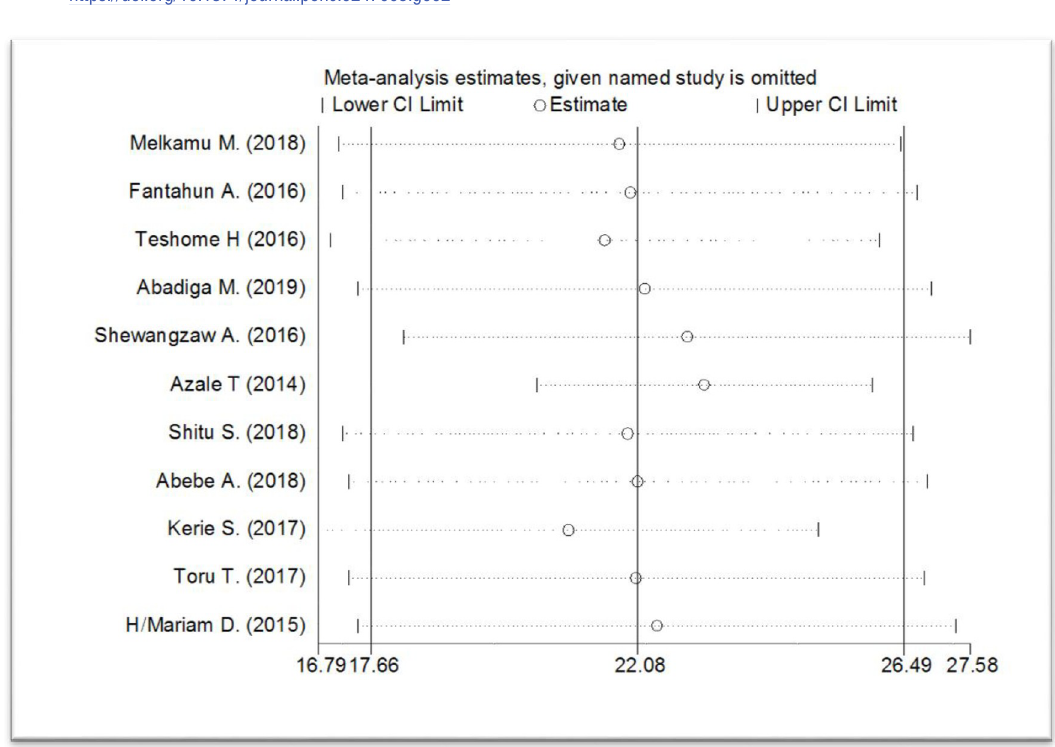
Fig 2. Forest plot presenting of publication bias of post-partum depression among after child giving mothers, Ethiopia, 2020.